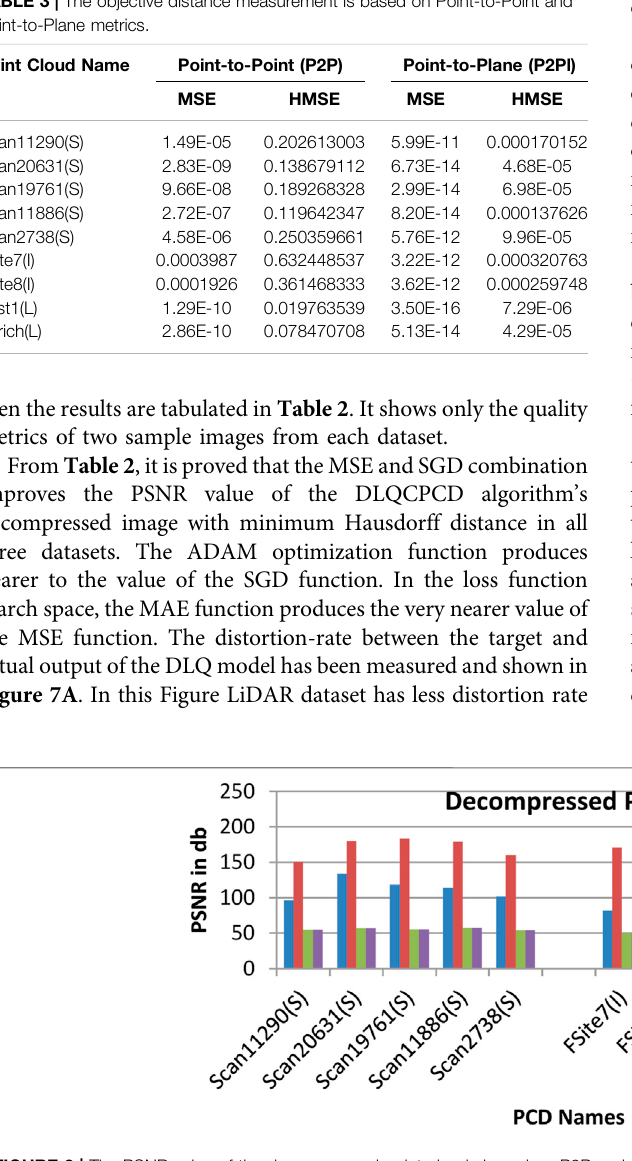
Frontiers in Robotics and AI |